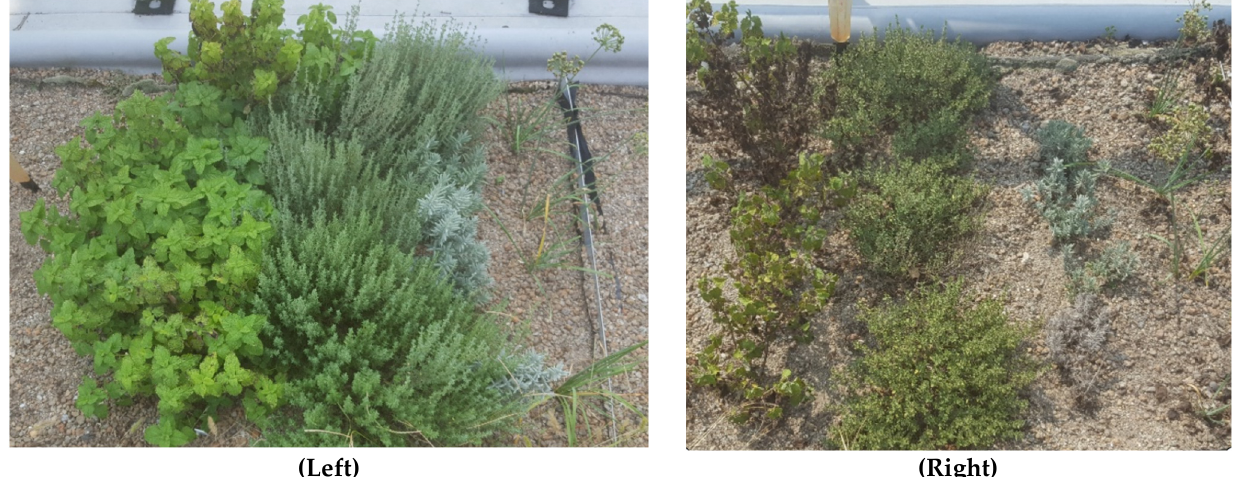
Figure 1. Comparison of watering regimes (1 L per plant) of twice per week ( left ) and once every two weeks ( right ) for the green roof perennial herb experiment.